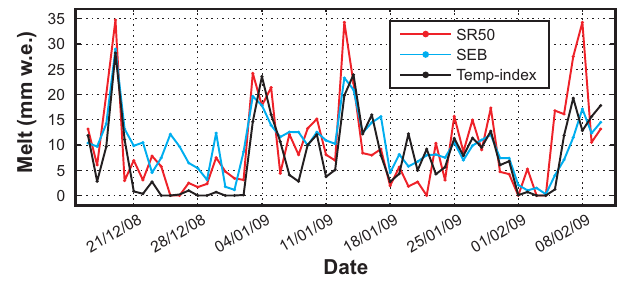
Fig. 8. Surface melt at the position of the AWS according to the surface lowering registered by the ultra-sonic ranger (SR50), SEB calculations and temperature-radiation index model for part of the model calibration